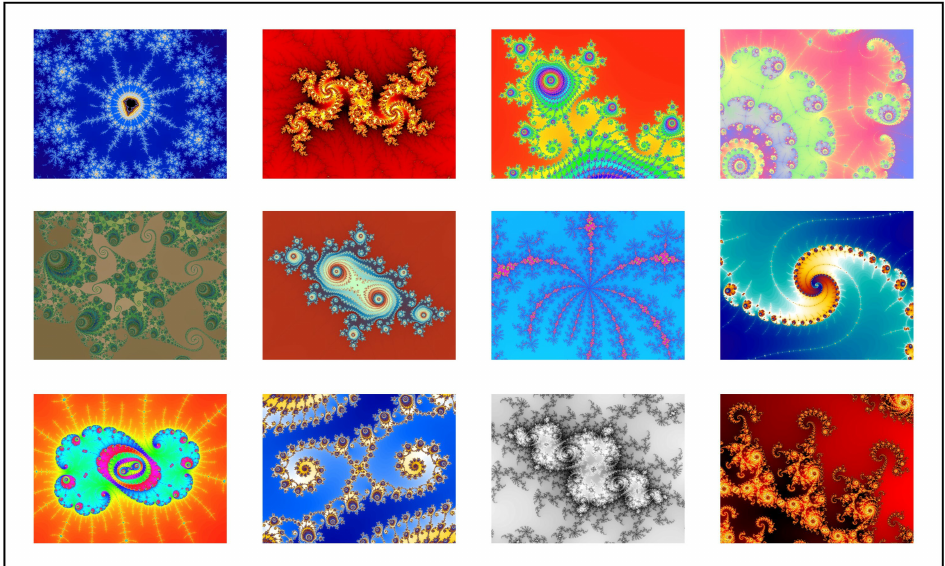
Figure 22. Mandelbrot Calendar 2021. Images courtesy: David Eck, http://math.hws.edu/eck/mb2 1/ (accessed on 20 October